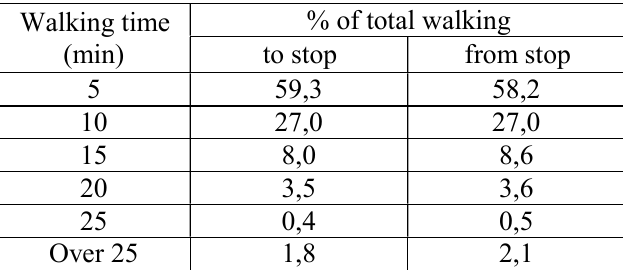
Table 3. Walking time to and from the